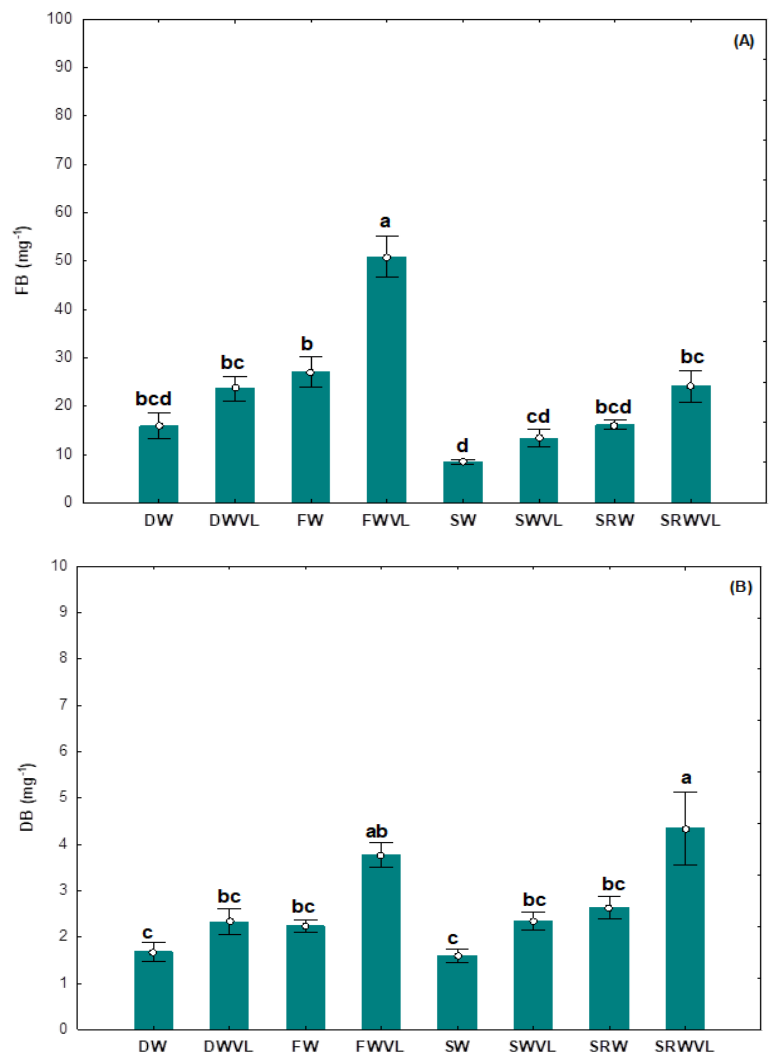
Figure 7. ( A ) Fresh biomass (FB), and ( B ) dry biomass (DB) of Salicornia bigelovii seedlings under different water treatments. Same letters above bars denote no-significant differences, vertical lines bars at the top of bars are the standard deviation ( n = 4).